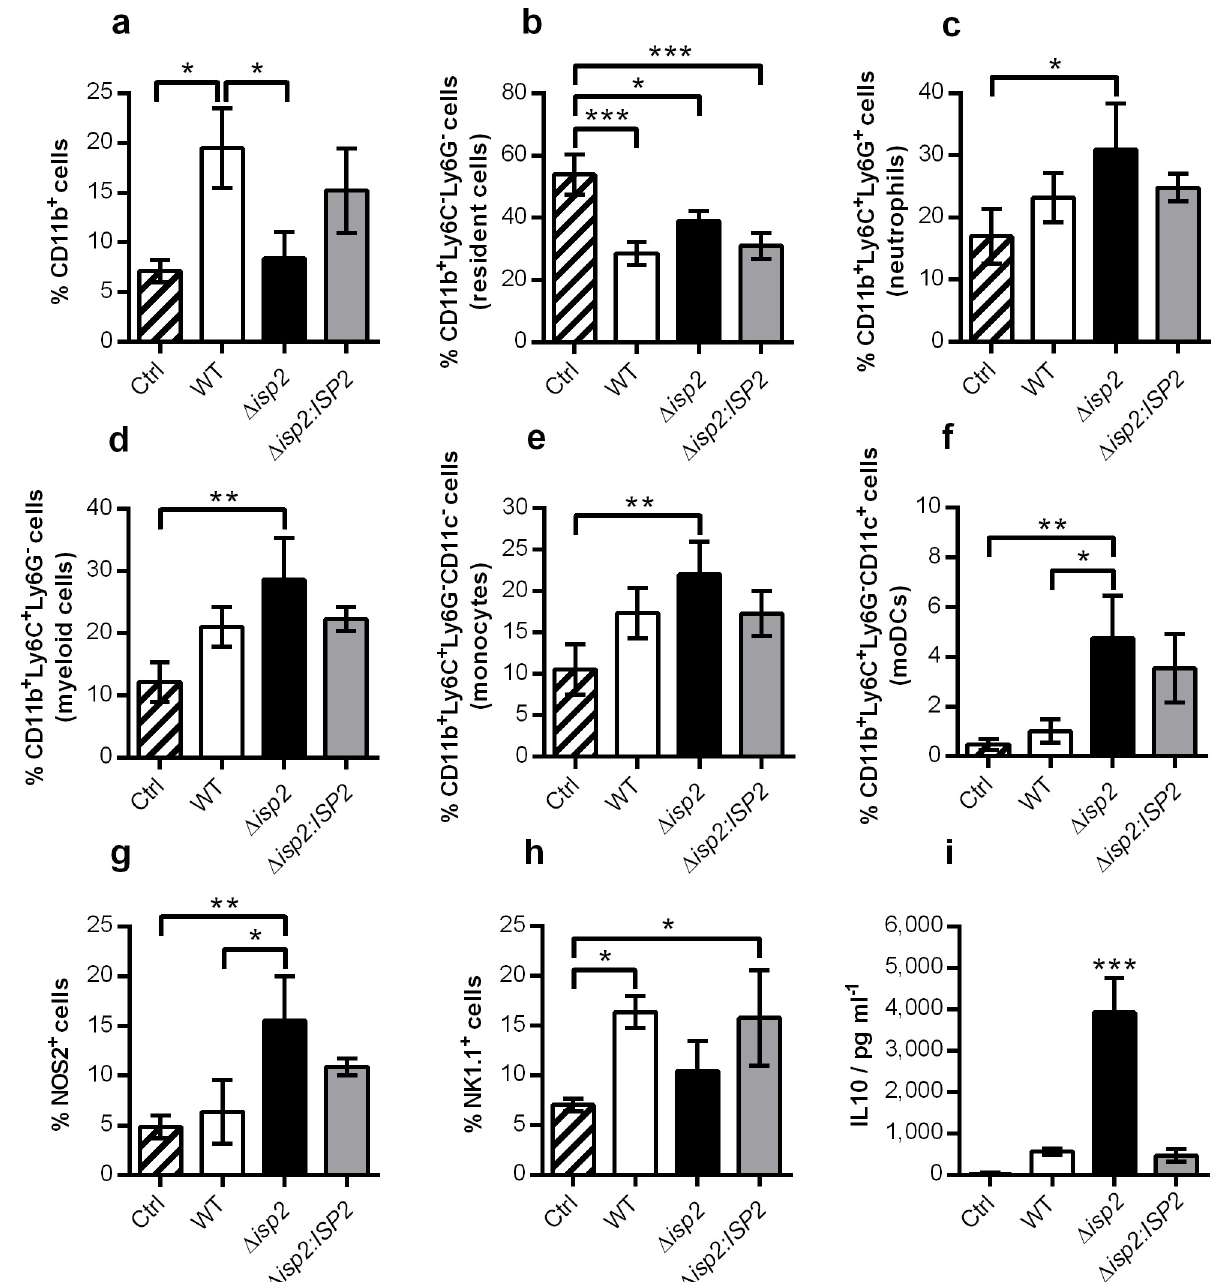
Fig 9. Enhanced NOS2 + populations in the spleen of mice infected with Δ isp2 T . b . rhodesiense during late infection. C57BL/6 mice were infected intraperitoneally with 1 × 10 5 T . b . rhodesiense WT, Δ isp2 and Δ isp2 : ISP2 . Uninfected mice were used as a control (Ctrl). After 13 days mice were euthanized, perfused, and the spleens were removed and homogenized. Cell suspensions were stained with antibodies for extracellular and intracellular markers for flow cytometry. Graphs show the percentage of cell subsets within the spleen. Cells were first gated to exclude debris using the FSC vs. SSC plot, followed by FSC-H vs. FSC-A to exclude doublets. For (a-f) CD11b + cells were selected from a SSC vs. PE-CD11b plot. From the CD11b + cells, a BV605-Ly6C vs. APC-Ly6G plot was generated to identify neutrophils (Ly6C + Ly6G + ), resident cells (Ly6C - Ly6G - ) and myeloid (Ly6C + Ly6G - ) cells. From the myeloid cells, a further plot using SSC vs. PerCP-Cy5.5-CD11c was used to identify CD11c - and CD11c + cells. For (g) CD11b + cells selected as described above were gated for the NOS2 + cells using a SSC vs. PE-NOS2 plot. For (h) NK1.1 + cells were selected using a SSC vs. BV421-NK1.1. Gating strategies are given in S4 and S5 Figs. Graphs show the percentage of (a) CD11b + cells, (b) CD11b + Ly6C - Ly6G - cells (resident cells), (c) CD11b + Ly6C + Ly6G + cells (neutrophils), (d) CD11b + Ly6C + Ly6G - (myeloid cells), (e) CD11b + Ly6C + Ly6G - CD11c - (monocytes), (f) CD11b + Ly6C + Ly6G - CD11c + (monocyte-derived dendritic cells, moDCs), (g) NOS2 + cells within the CD11b + population and (h) NK1.1 + cells (natural killer cells, NK cells). In (i), spleens were centrifuged and the supernatants were collected. IL10 levels in the pooled samples of mice of the same group